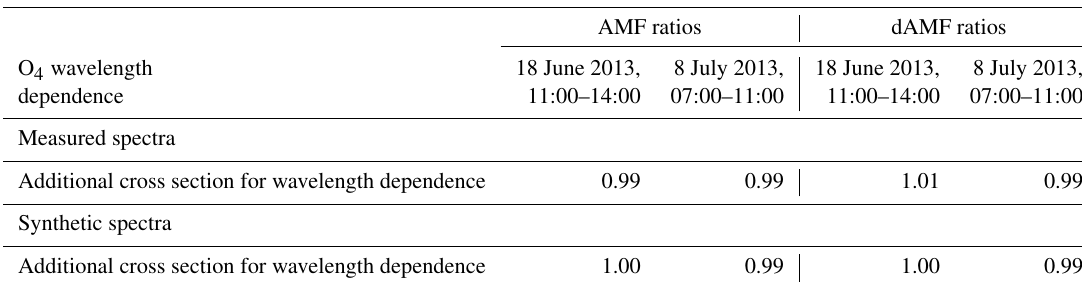
Table A20. Average ratios of O 4 (d)AMFs derived for the analysis with a second O 4 cross section (accounting for the wavelength depen- dence) vs. those for the standard analysis (only one O 4 cross section) for the middle period on each selected day (top: results for spectra measured by the MPIC instrument; bottom: results for synthetic spectra when taking into account the temperature dependence of the O 4 cross